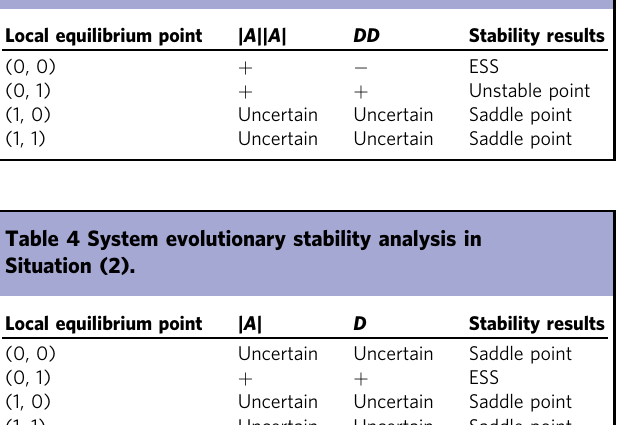
Table 3 System evolutionary stability analysis in Situation (1).